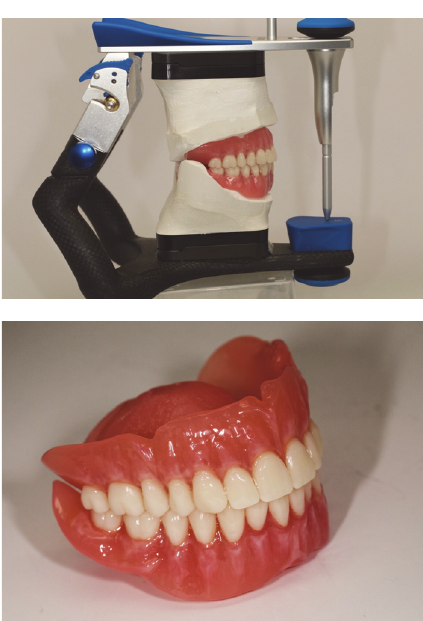
Figure 12: Final denture.